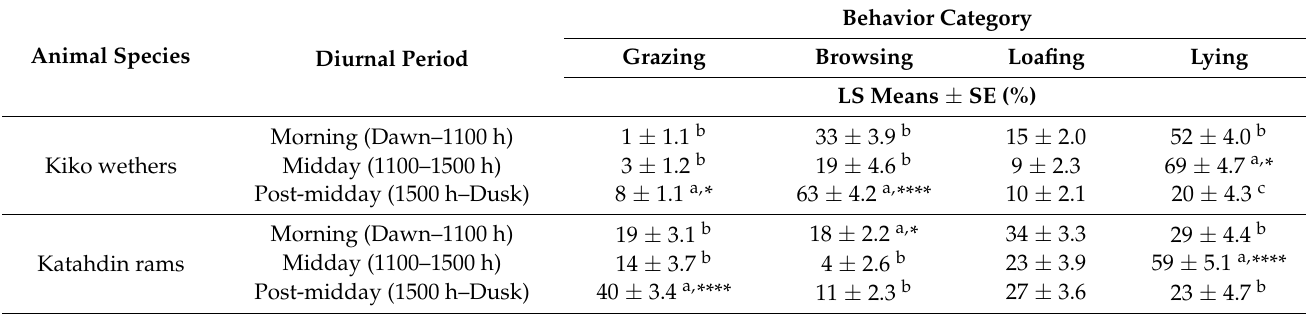
Table 3. Diurnal (dawn–dusk) time spent by Kiko wethers and Katahdin rams in woodlands, June–August 2018. Behavior Category Animal Species Diurnal Period Grazing Browsing Loafing Lying LS Means ± SE (%) Morning (Dawn–1100 h) 1 ± 1.1 Kiko wethers